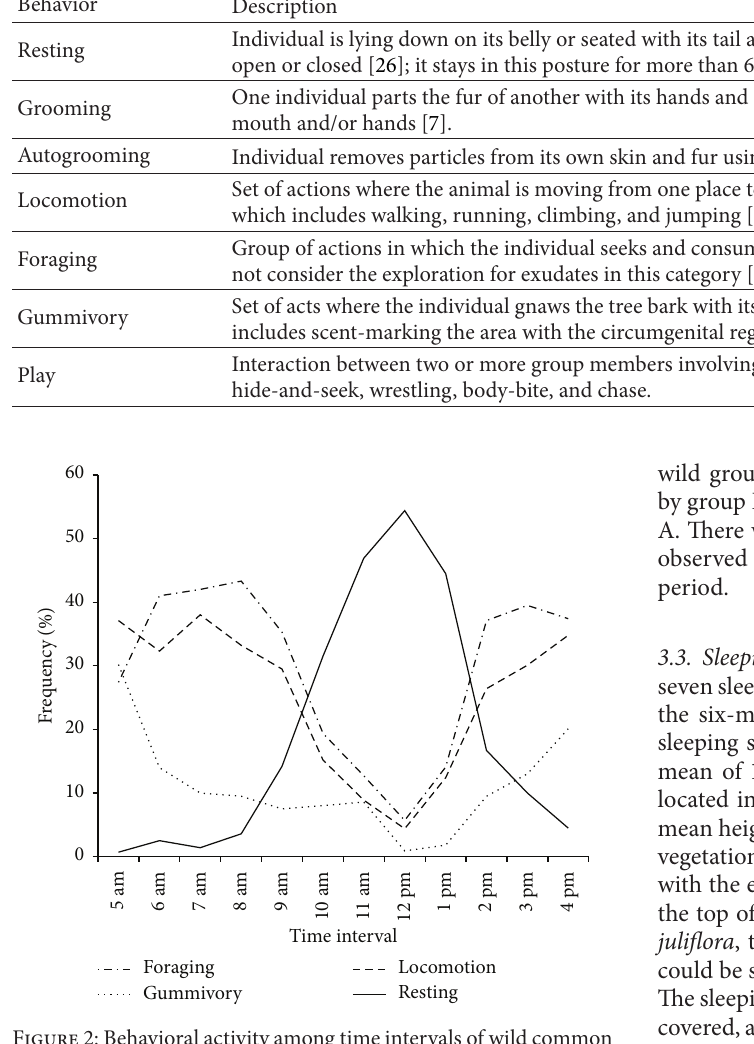
Figure 2: Behavioral activity among time intervals of wild common marmosets ( 𝑛 = 10 ) in the